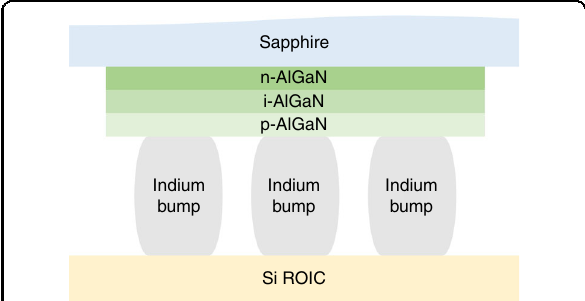
Fig. 16 Hybrid-packaged AlGaN focal plane arrays. Indium bump for FPA interconnect AlGaN solar-blind UV photodetector with silicon